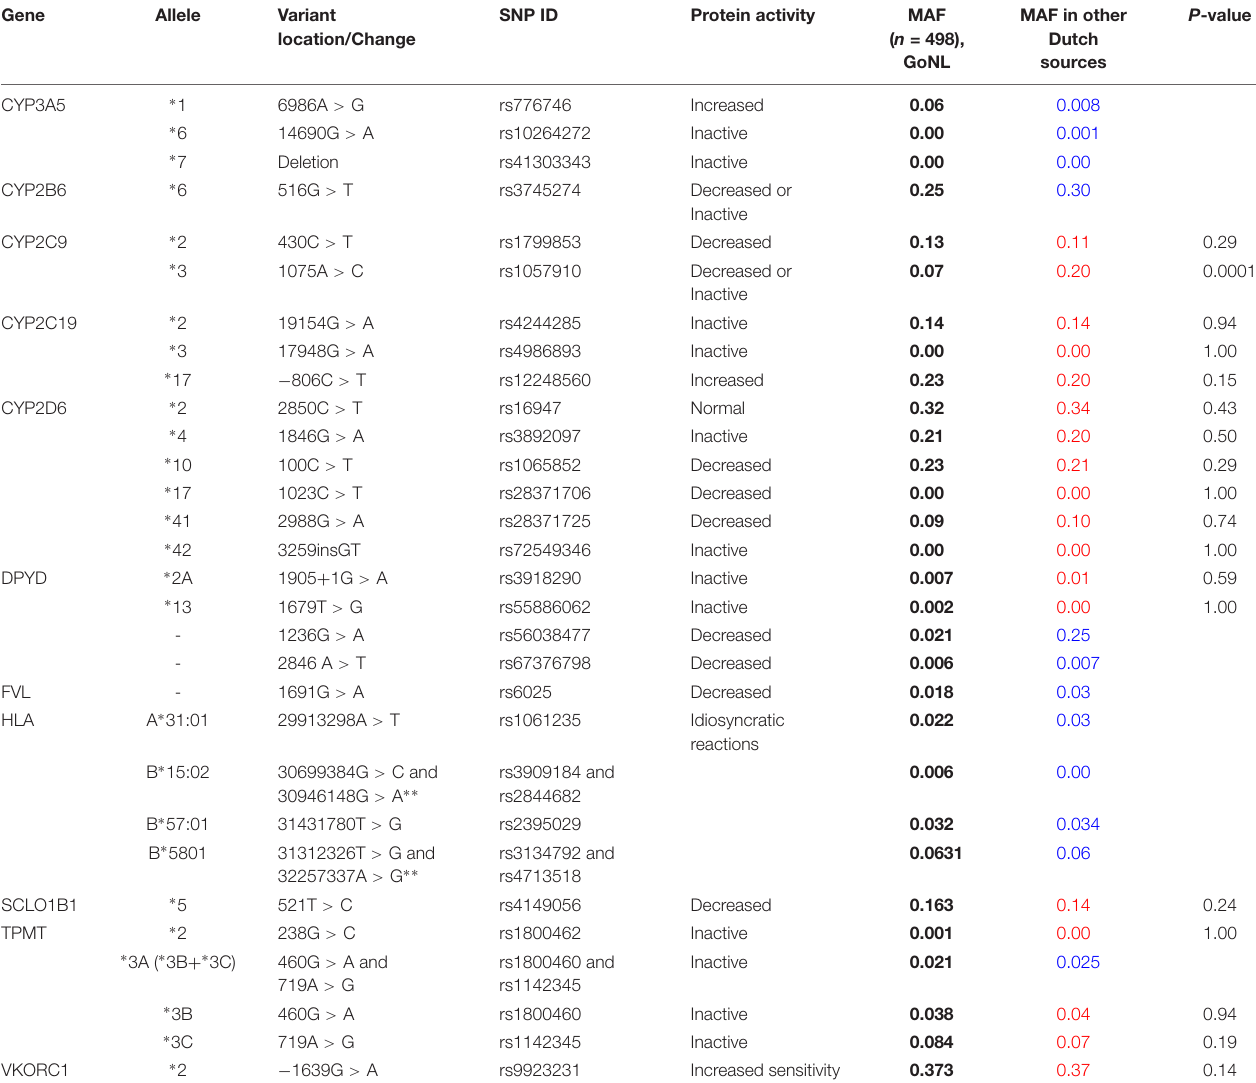
TABLE 1 | Frequency of the common variants located in pharmacogenes among Duch population: GoNL data versus other Dutch genetic databases. Gene Allele Variant SNP ID Protein activity MAF location/Change